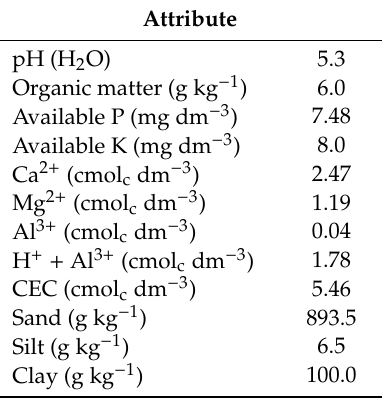
Table 1. Data from chemical and physical analysis of the soil in preplant in the experimental site (0.00–0.20 m layer).